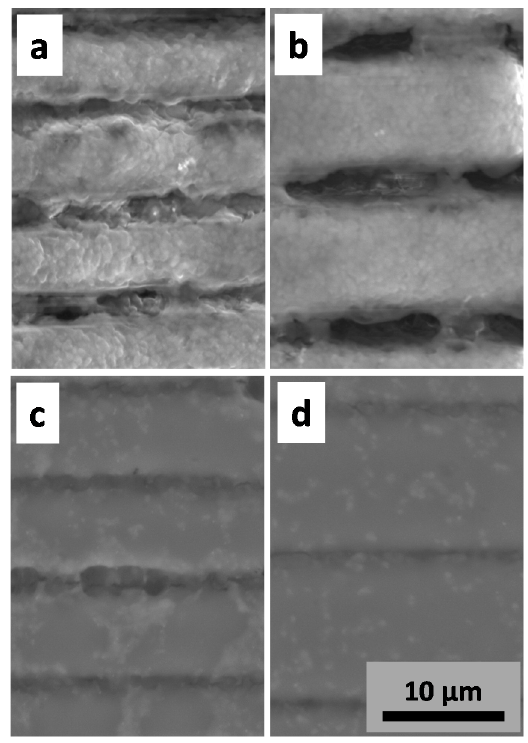
Figure 5. SEM images of microenvironments with biofilm formation on the 8 μ m ( a ) and 12 μ m ( b ) micropatterned PMMA surface; and 8 μ m ( c ) and 12 μ m ( d ) micropatterned chitosan surface.